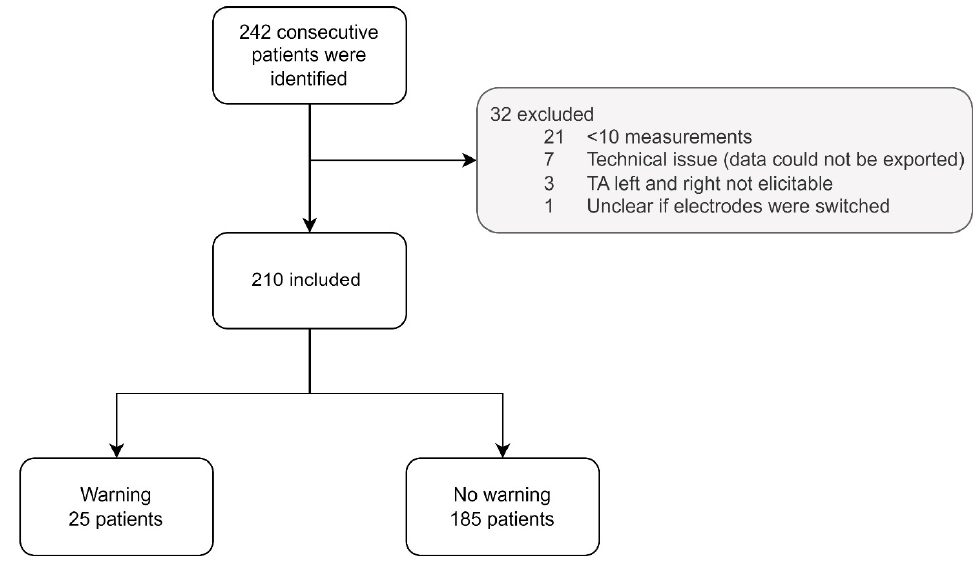
Figure 1. Flowchart patient selection. TA, tibialis anterior muscle.